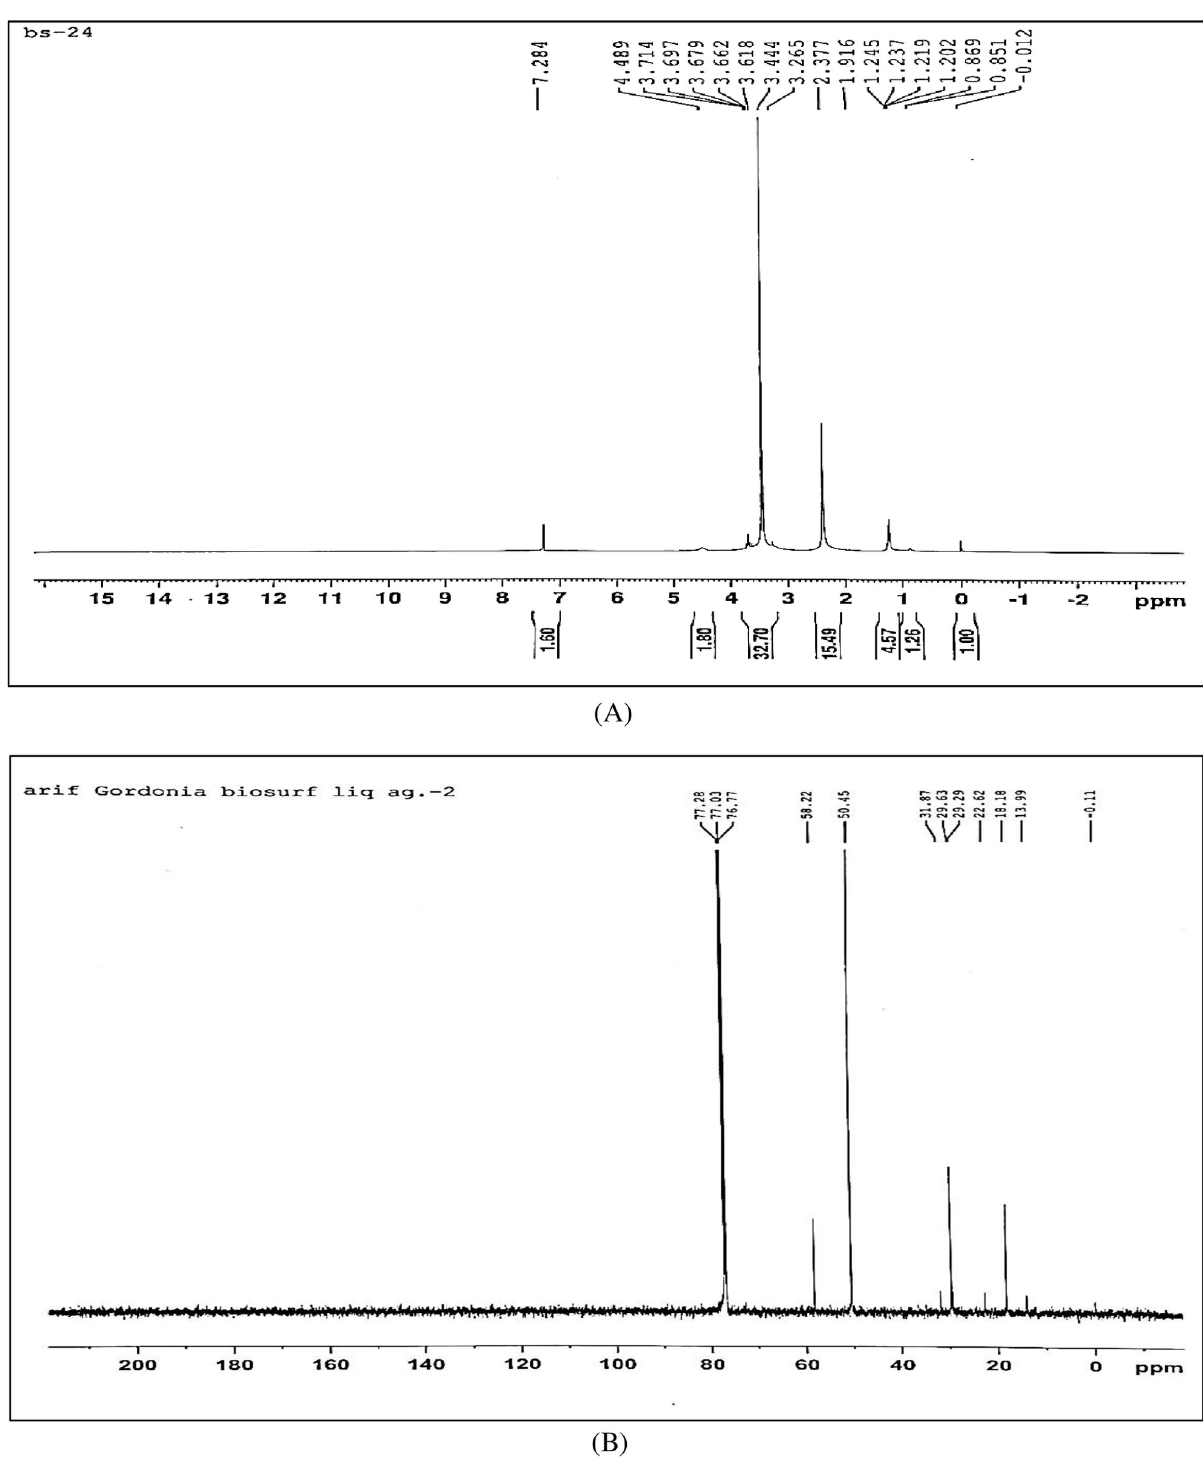
Fig 10. NMR of biosurfactant produced by Gordonia sp. IITR 100. (A) H 1 NMR (B) C 13 NMR.